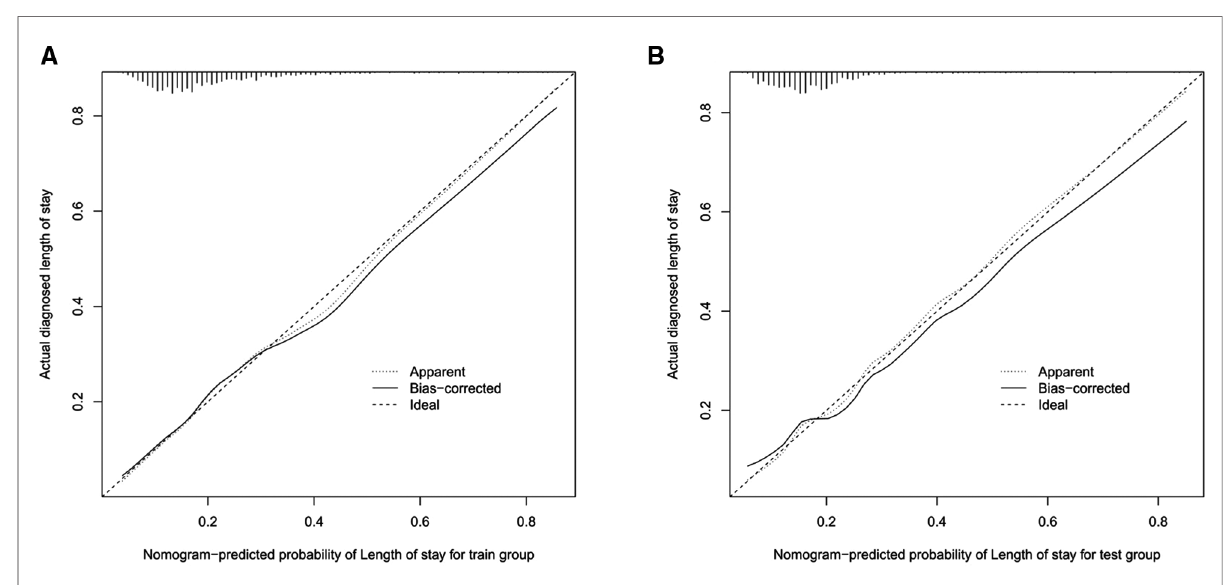
FIGURE 4 The Calibration curves of prolonged hospital stay in the training set ( A ) and validation set ( B